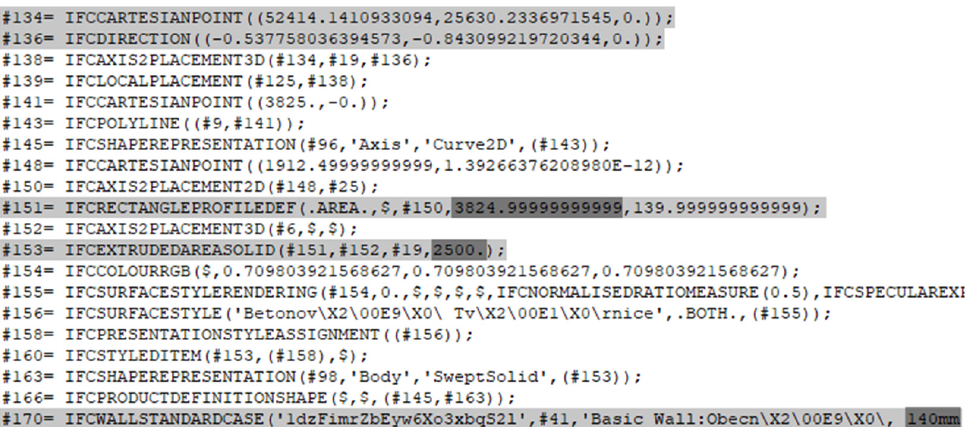
Figure 2. Identification of wall geometry in IFC.